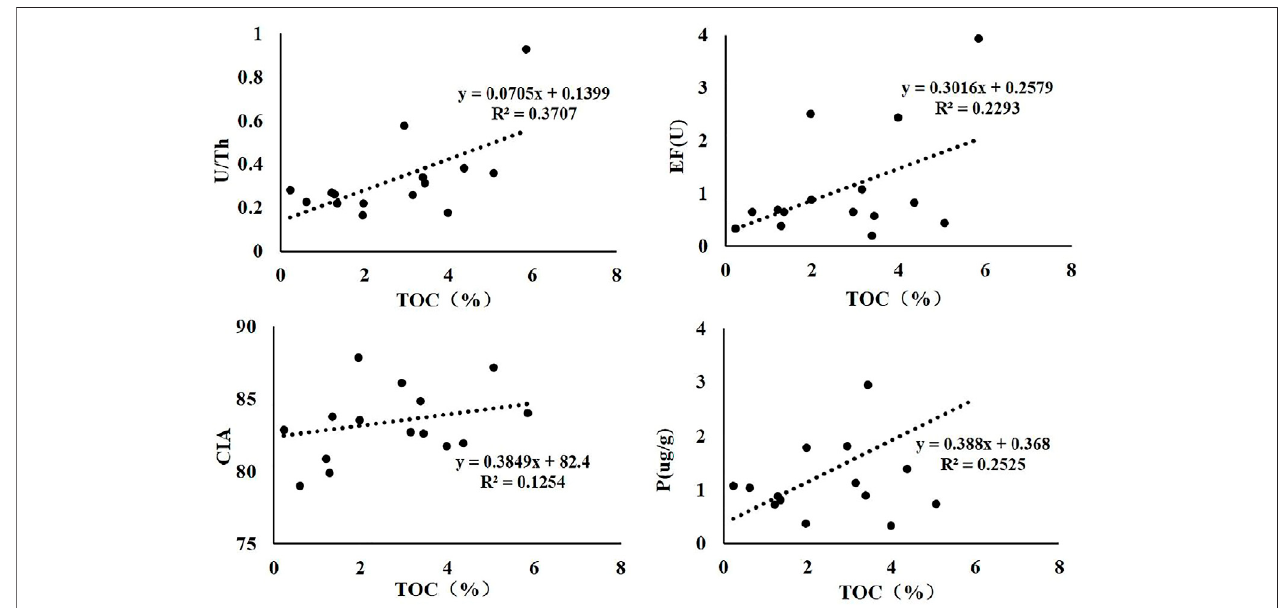
FIGURE 9 | Correlations between TOC and redox properties, paleoproductivity, and paleoclimate indicators of Longtan Formation shale in Well X1 in the study area.